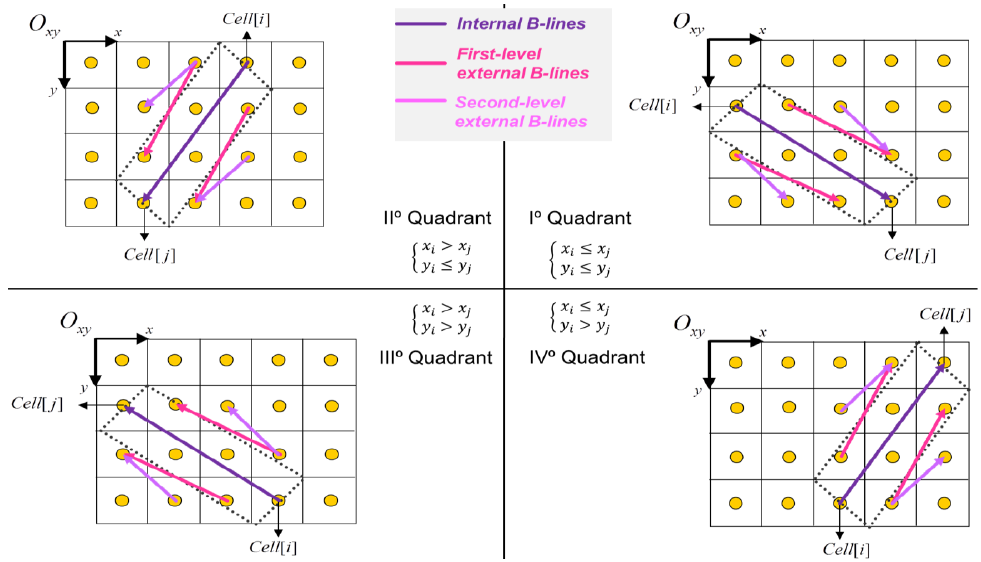
Figure 3. Definition of the Bresenham‟s lines set in the four